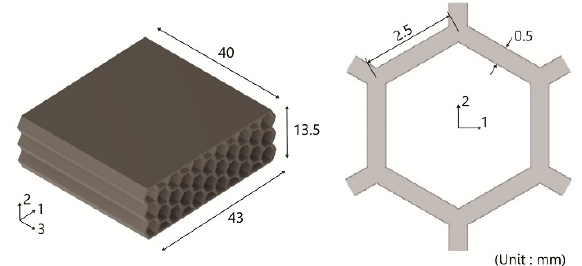
Figure 5. Dimensions for the ball rebound test.